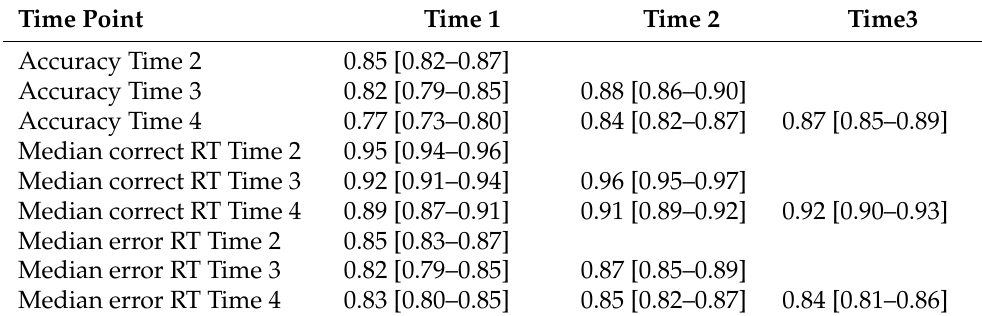
Table A10. Correlation matrix of raw data across four time points across all